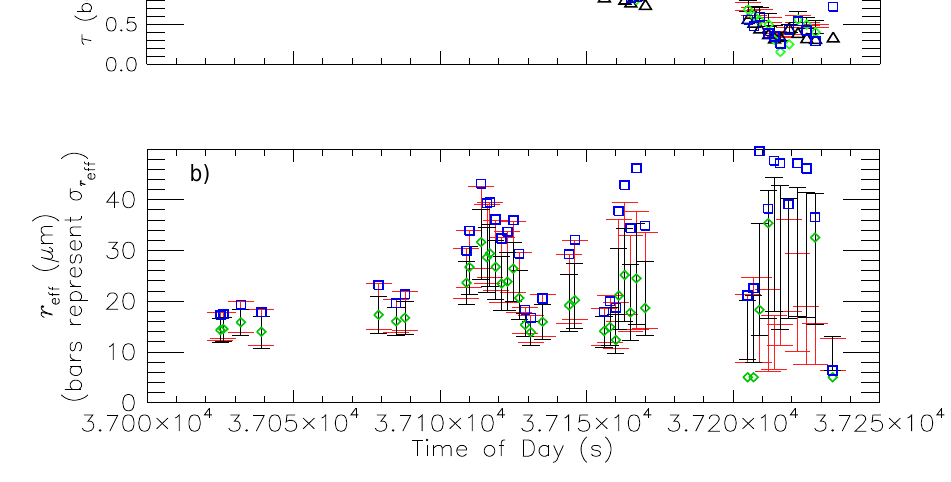
Fig. 14. Same as Fig. 12 but for 3 November 2010.